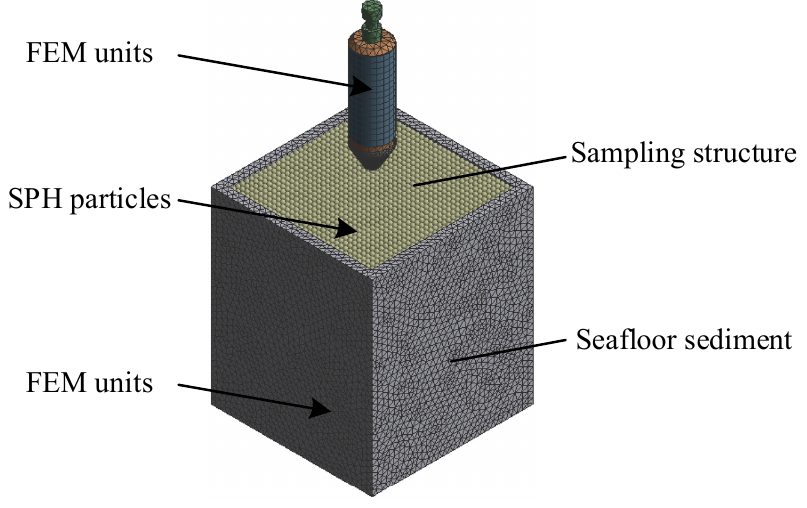
Figure 6. The FEM-SPH coupled model.